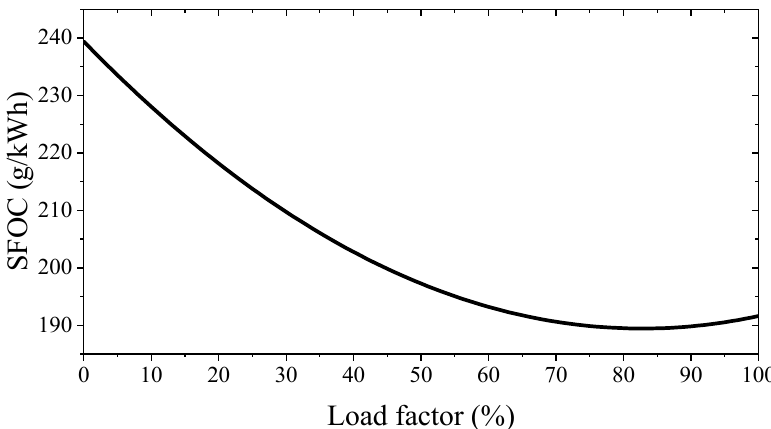
Figure 6. Specification fuel oil consumption curve (SFOC). Accordingly, the power generation efficiency can be obtained using Equation